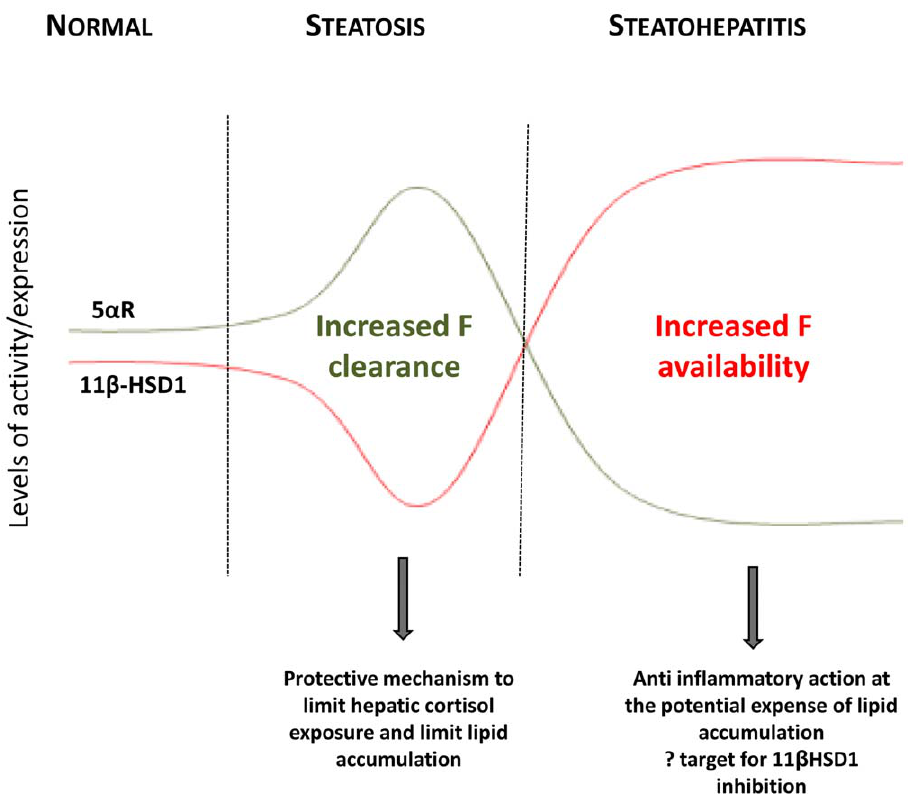
Figure 5. Schematic: Hepatic glucocorticoid metabolism and its modulation in response to disease progression in NAFLD.